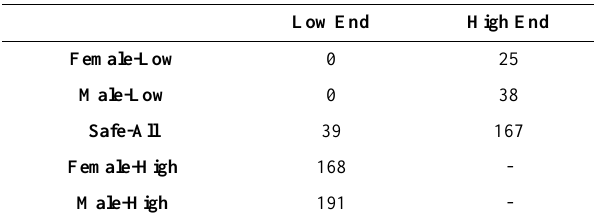
Table 2. Categorization of data.